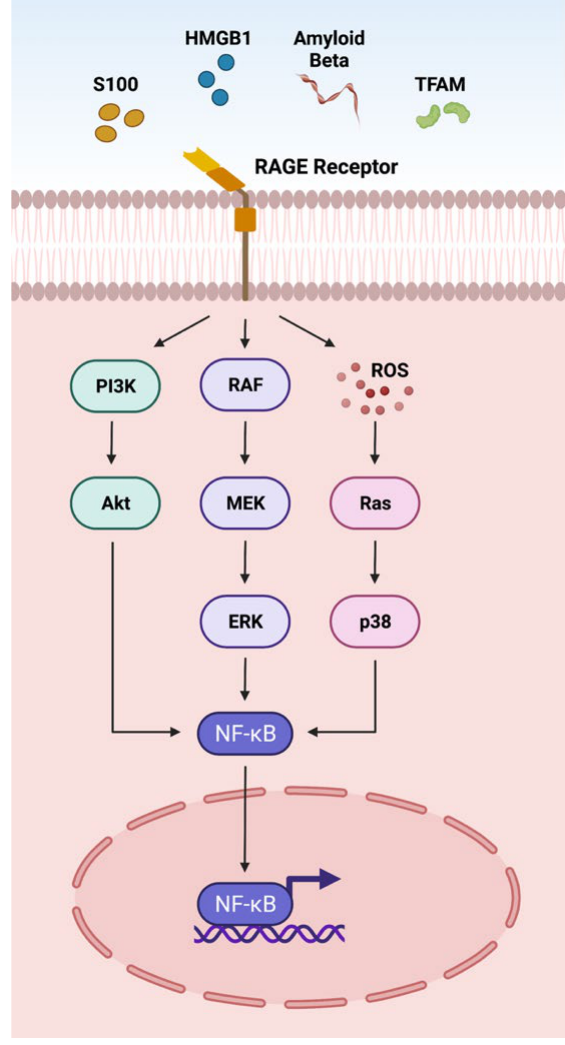
Figure 1. Overview of the DAMPs activating the RAGE pathway. The receptor for advanced glycation end-products (RAGE) is a multi-ligand protein that integrates the immunoglobulin superfamily of receptors. RAGE recognizes a variety of DAMPs including S100, high mobility group box 1 protein (HMGB1), Amyloid beta (Aβ), and transcription factor A mitochondrial (TFAM). RAGE activation leads to downstream NFκB signaling and transcription of inflammatory factors.